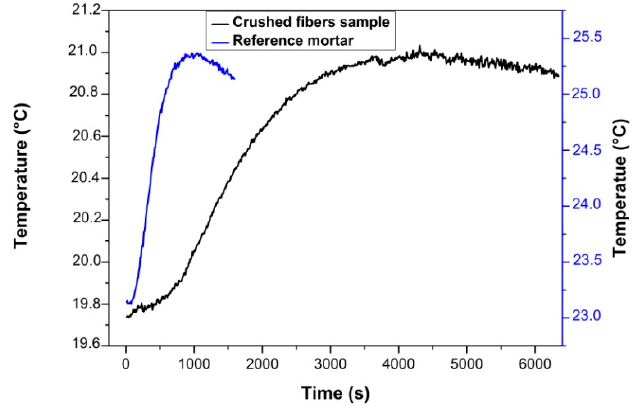
Figure 6. Experimental thermogram of opposite faces of crushed fibers and reference mortar sample.